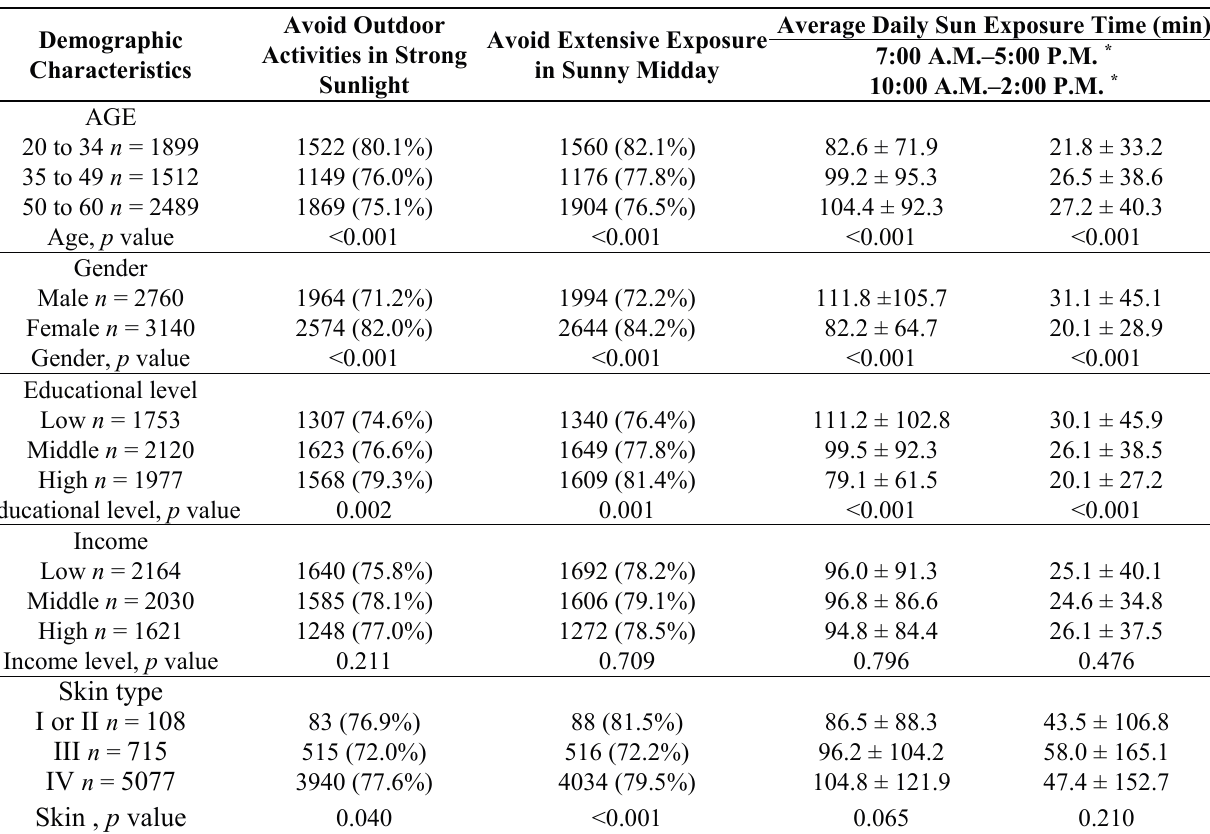
Table 5. Behaviors and duration of sun exposure of the 5900 responders, stratified by age, sex, education level and